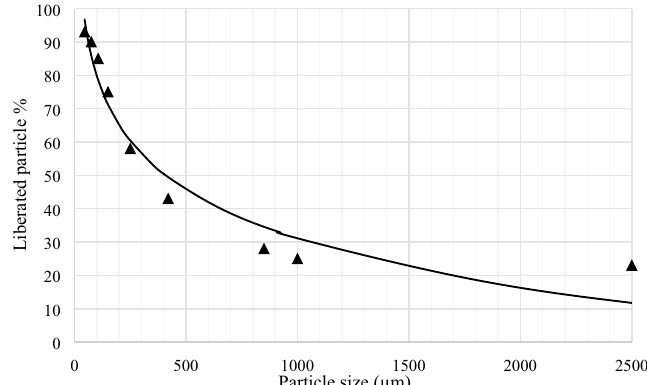
Figure 4. Graph of gilsonite liberation degree in terms of particle size in different particle size fractions.